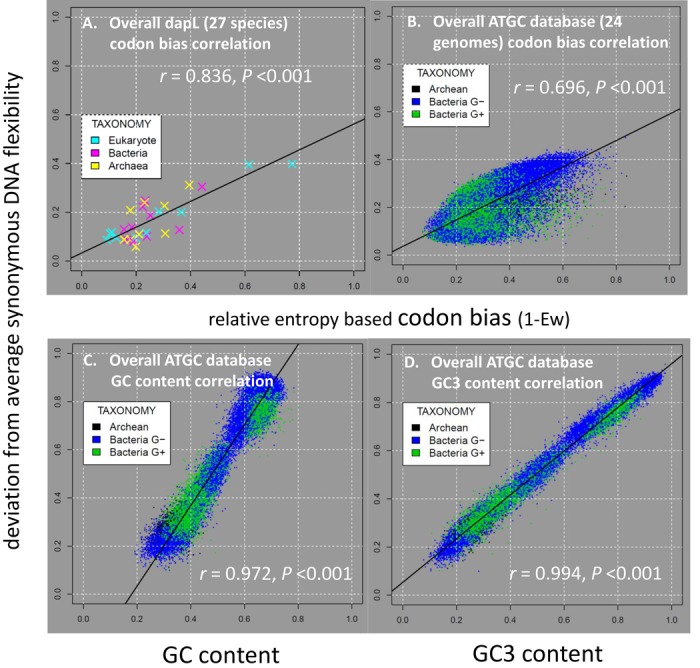
The positive association (r) of entropy-based codon bias (1-Ew) and gene-level deviations from synonymous flexibility for the given protein space for (A) the 27 dapL genes and (B) all 35 234 prokaryotic genes in the ATGC database (24 genomes). Examples of the deviation from average synonymous flexibility given its protein space for single genes are shown in Figure 5B–D (i.e. the mean devTRXcdn = abs[mean red line-mean black line]/[mean blue line - mean green line]). Also shown are the positive association of (C)overall gene GC content and (D) overall gene third position GC content (GC3) with gene-level deviations from synonymous flexibility for the given protein space.